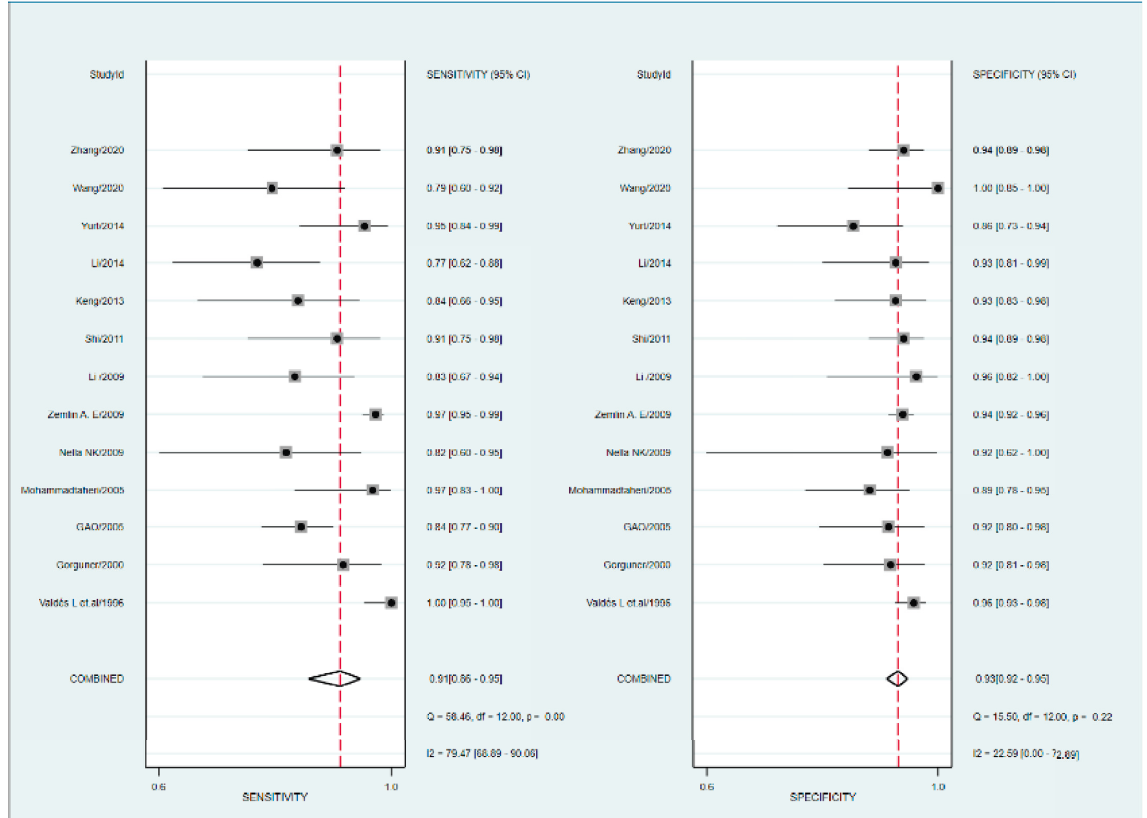
Figure 3: Forest plots of sensitivity and specificity for ADA2. The pooled sensitivity was 0.91 (95% CI: 0.86–0.95), and the pooled specificity was 0.93 (95% CI: